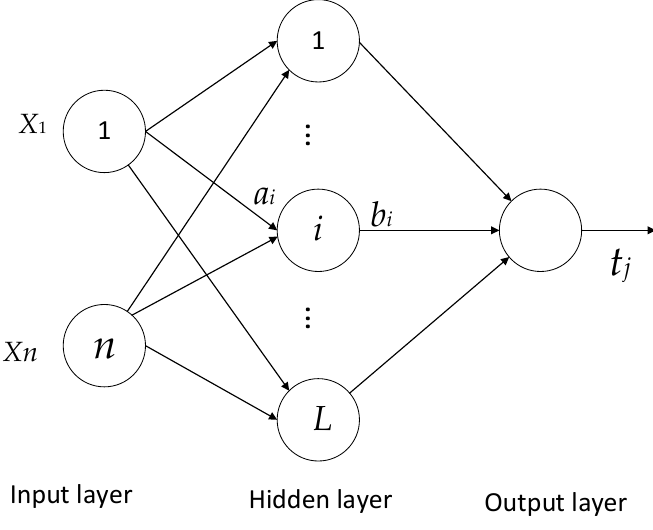
Figure 16. ELM network structure.